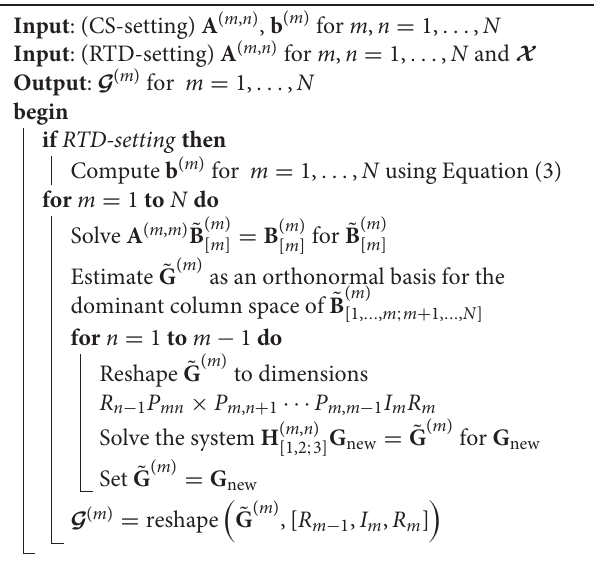
Algorithm 3: TT from a BRKS linear system ( lstt_brks